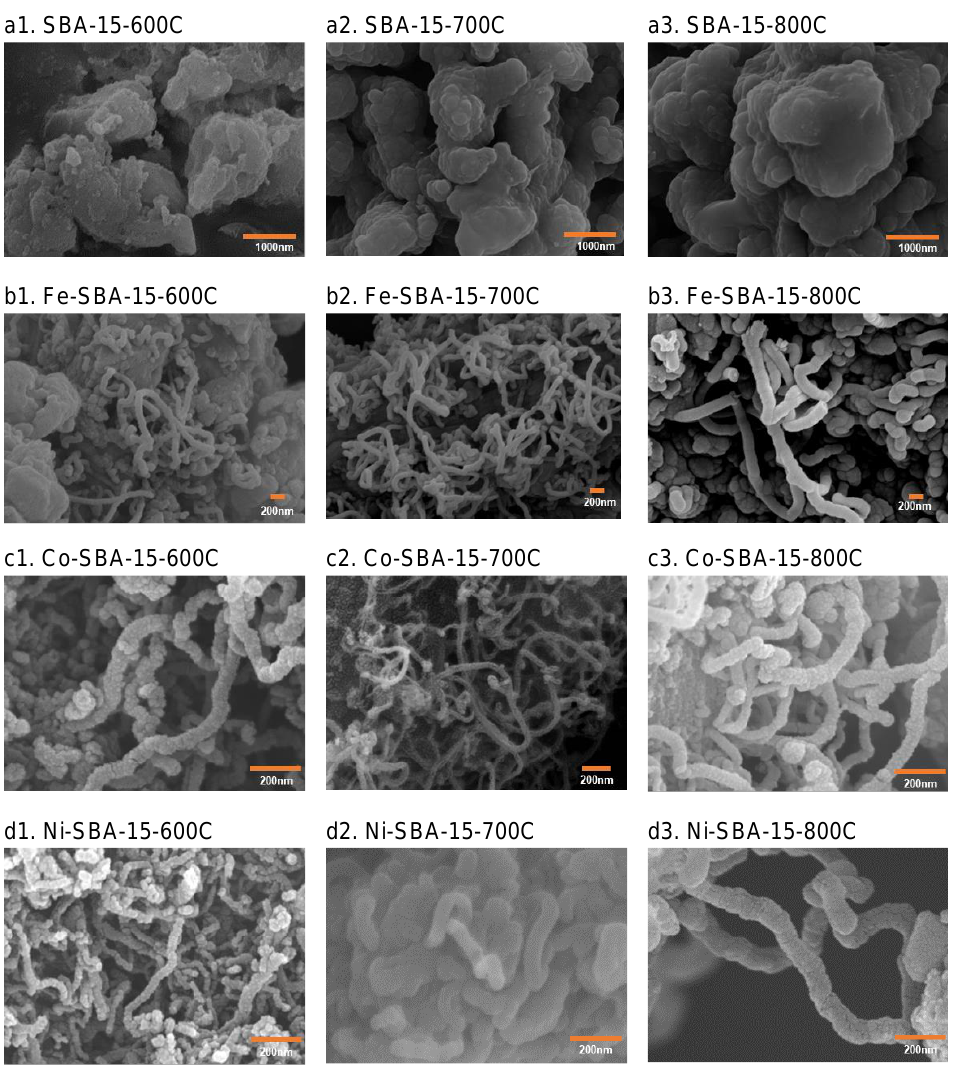
Figure 8. Carbon material formation on SBA-15 and Fe-, Co-, and Ni-SBA-15 after IPA decomposition at 600, 700, and 800 °C.